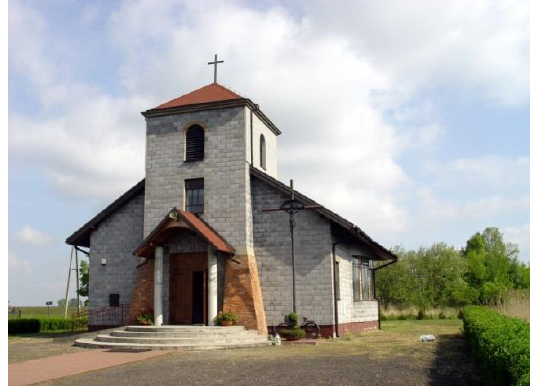
Figure 14. Church of St. Mary Magdalene in Huta Stara A (built in 1993–99).